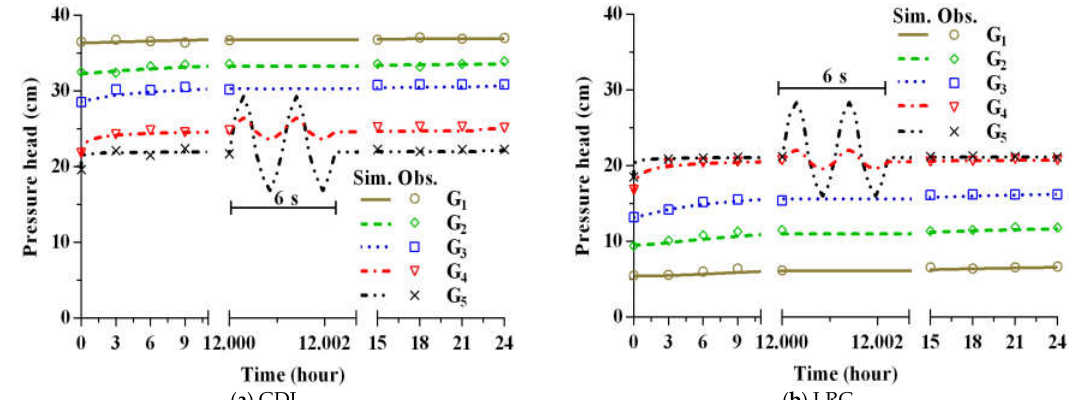
Figure 2. Simulated (lines) and observed (points) pressure heads during a one-day period after wind waves started in the GDL ( a ) and LRG ( b ) cases. All observation points were at the same height of 20 cm (Figure 1b). Except for time between 12.000 and 12.002 h, only values when the lake water level was at its mean position are shown.